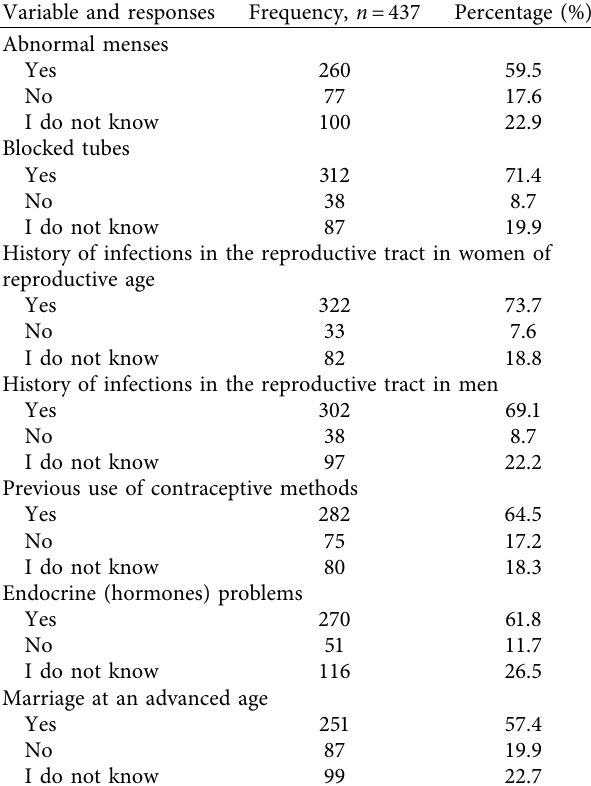
Table 4: These are some of the reasons for infertility that may need IVF.